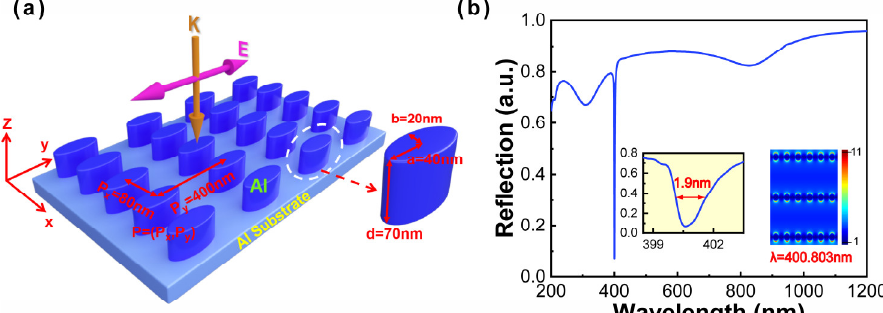
Figure 1. ( a ) Schematic diagram of the Al nanoellipse metasurface and the setting of structural parameters. ( b ) Reflectance spectrum of the Al nanoellipse metasurface with optimized parameters. The inset represents the zoomed-in image of the ultranarrow linewidth and near-field distribution of resonant wavelength corresponding to the ultranarrow